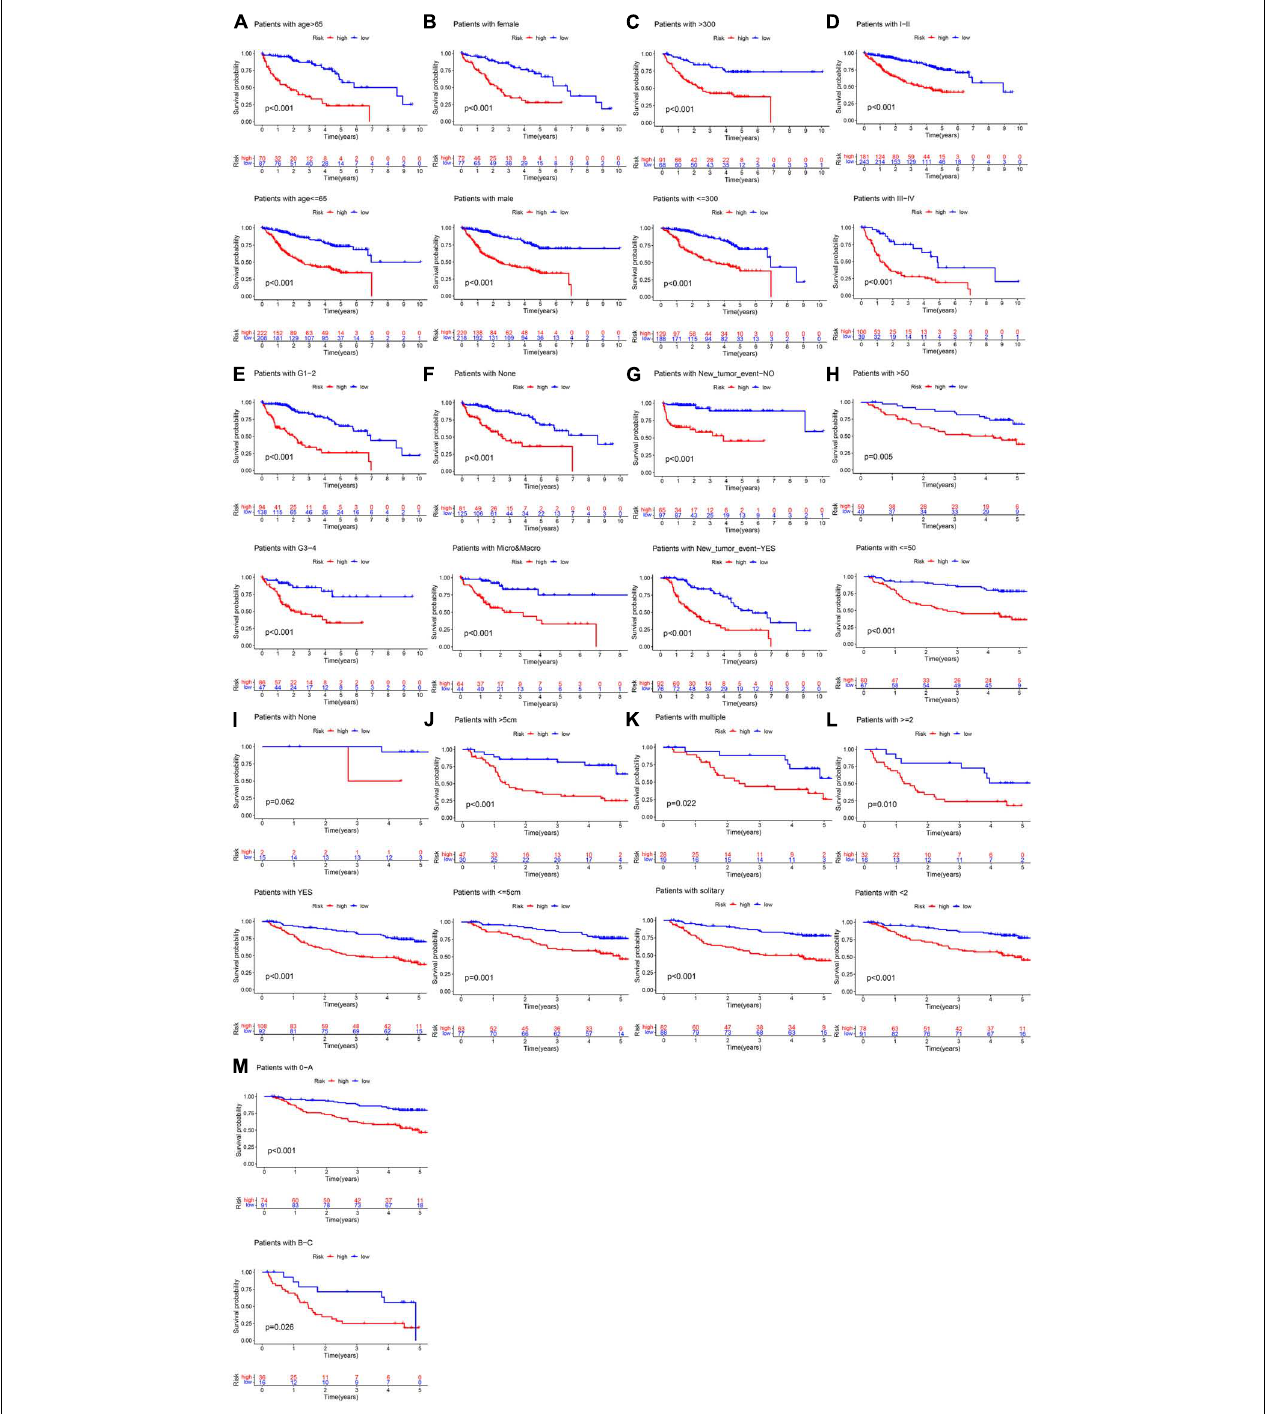
FIGURE 6 | Subgroup survival analysis in the training cohort. (A) Age. (B) Gender. (C) AFP (ng/ml). (D) TNM stage. (E) Histology grade. (F) Vascular tumor cell type. (G) New tumor event after initiative treatment. (H) ALT. (I) Cirrhosis. (J) Main tumor size. (K) Tumor type. (L) CLIP_Score. (M) BCLC stage.